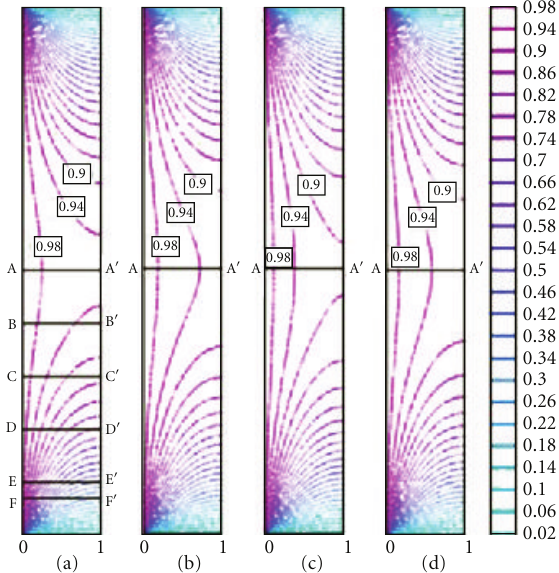
Figure 7: Distribution of dimensionless overpotential at T = 333 K, c 0 M = 1 . 0 M, E 0 = 0 . 4 V, κ e = 3 . 4 Ω − 1 m − 1 , D e = 3 . 04 × 10 − 10 m 2 s − 1 ; (a) l = 10 μ m, a = 1 . 0 × 10 5 m − 1 ; (b) l = 25 μ m, a = 1 . 0 × 10 5 m − 1 ;